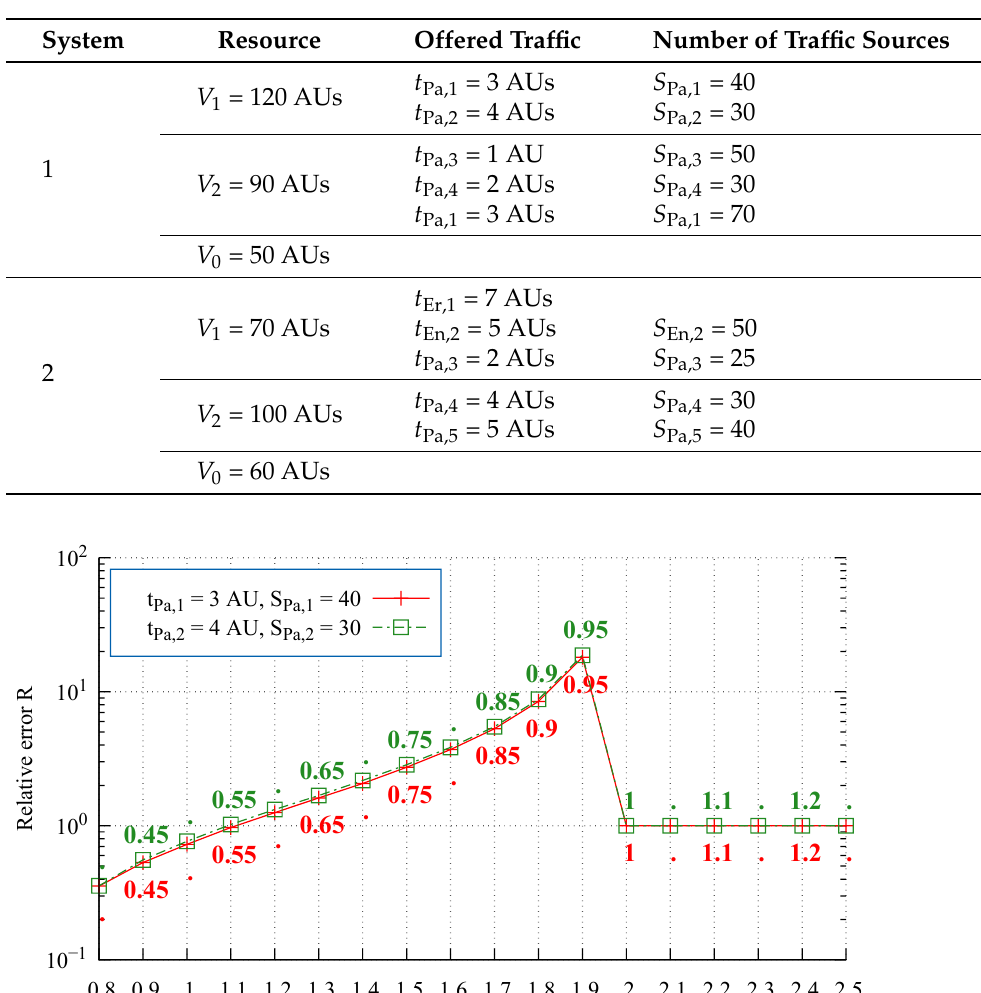
Table 1. The parameters of the multi-service systems.